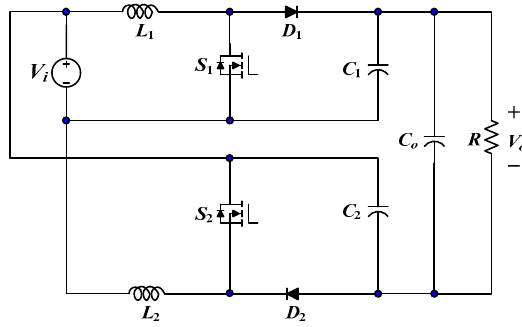
Figure 2. Proposed combined boost converter topology.